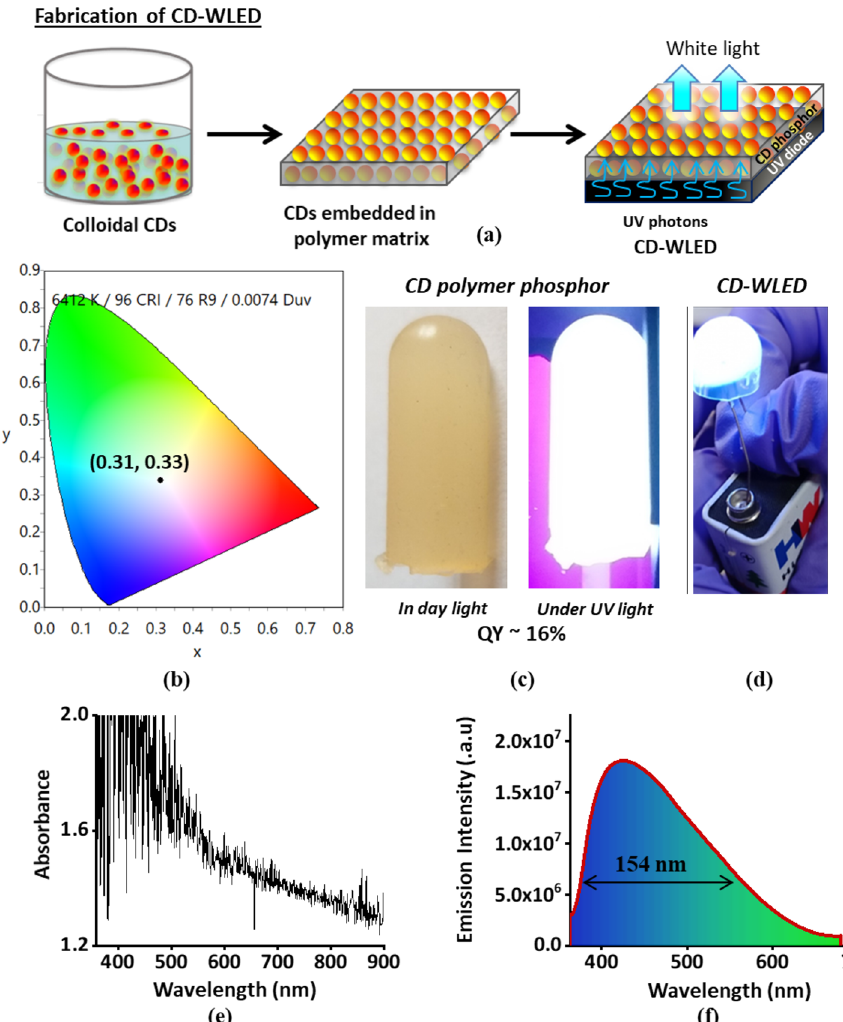
Figure 7. ( a ) Schematic of fabrication of CD-WLED. ( b ) Shows CIE color co-ordinates of fabricated CD polymer phosphor. White light emitted from CD phosphor show CIE chromatic co-ordinates of (0.31, 0.33) and a CRI of ~ 96 making it as an excellent phosphor for lighting systems. ( c ) CD polymer under visible light and under UV light illumination ( d ) Preliminary demonstration of polymer coated UV-LED (fabricated by us in our lab) which acts as white light emitting diode (WLED) ( e ) Absorption and ( f ) Emission spectra of CD polymer phosphor. CD polymer phosphor exhibits a broad absorption band ranged at ~ 350−700 nm. Under 350 nm excitation, CD polymer phosphor produce very broad white emission band ranging from 360 to 700 nm with a bandwidth of ~ 154 nm that favors bright white light